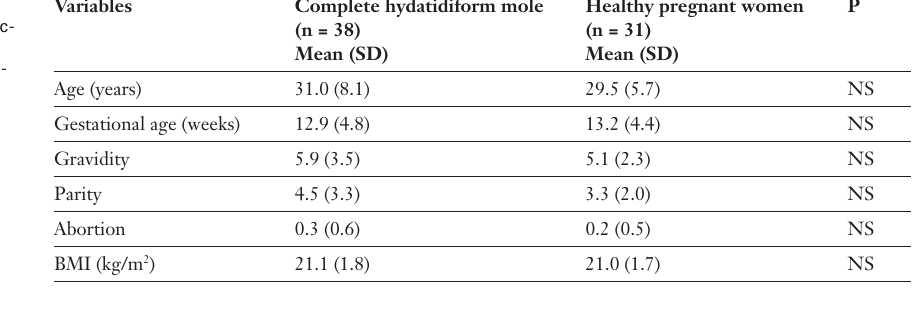
Table 2 Plasma indicators of oxidative stress in patients with com- plete hydatidiform mole (CHM) and healthy pregnant